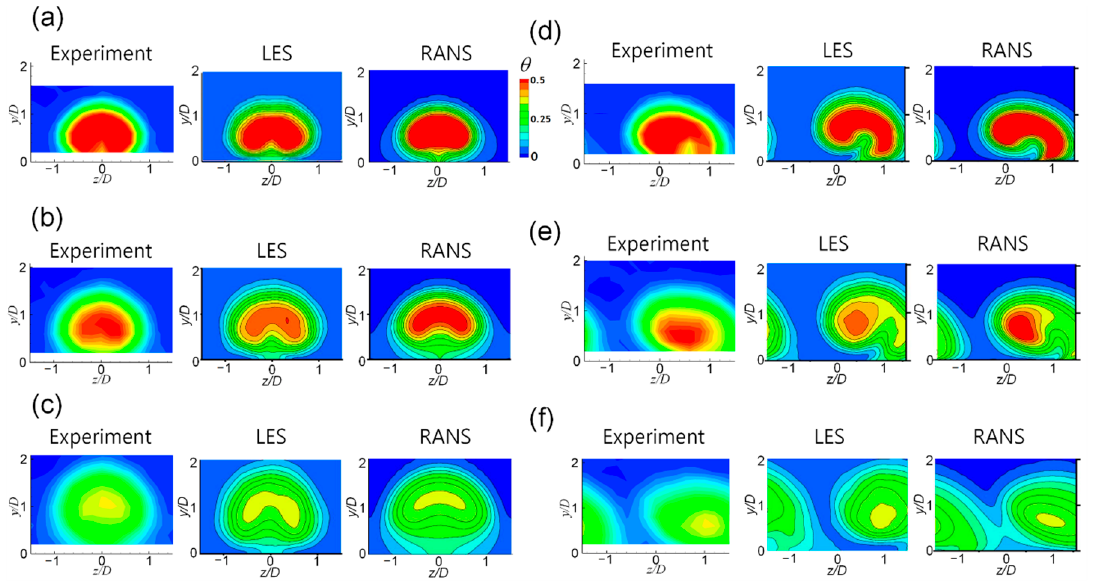
Figure 6. Boundary layer temperature distributions in the streamwise normal planes at M = 1.0: ( a ) x/D = 2.5, β = 0°; ( b ) x/D = 5.0, β = 0°; ( c ) x/D = 10.0, β = 0°; ( d ) x/D = 2.5, β = 30°; ( e ) x/D = 5.0, β = 30°; and ( f ) x/D = 10.0, β = 30°.